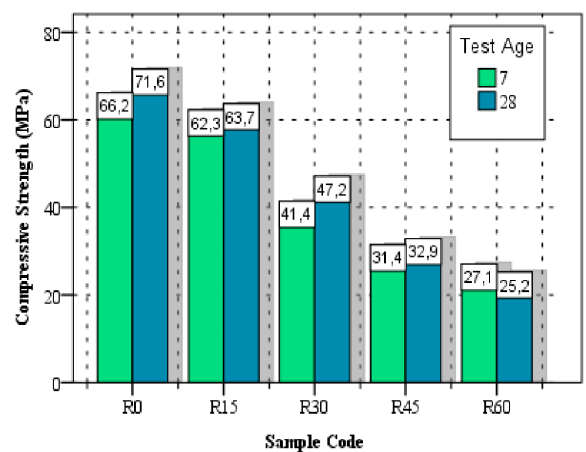
Figure 4. Test results of compressive strength of rubberized SCC [6]. Reproduced with